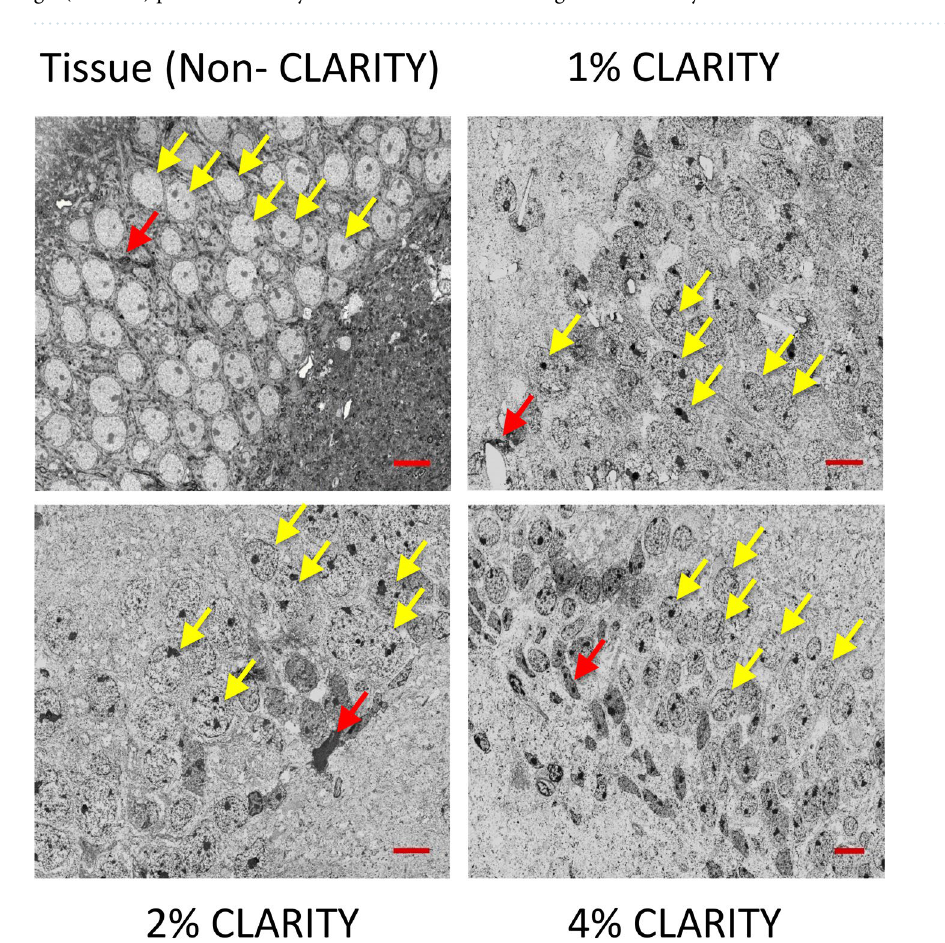
Figure 4. Comparison of preserved cellular morphology at different AAm concentrations (shown in subpanel labels) in SEM images of 200 nm sections of CA1 pyramidal region. Yellow arrows mark granule cells, red mark glial cells. Scale bar is 10